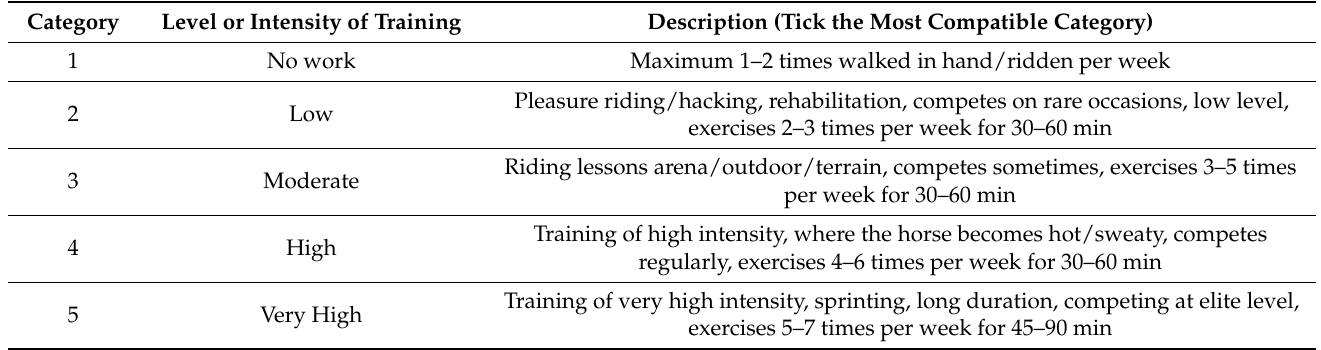
Table 1. Categories for level of training, including